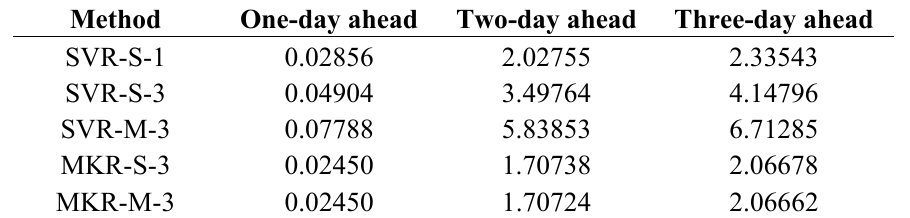
Table 5. Average RMSE/mean results for WTI Crude oil price prediction (total 14 experiments).